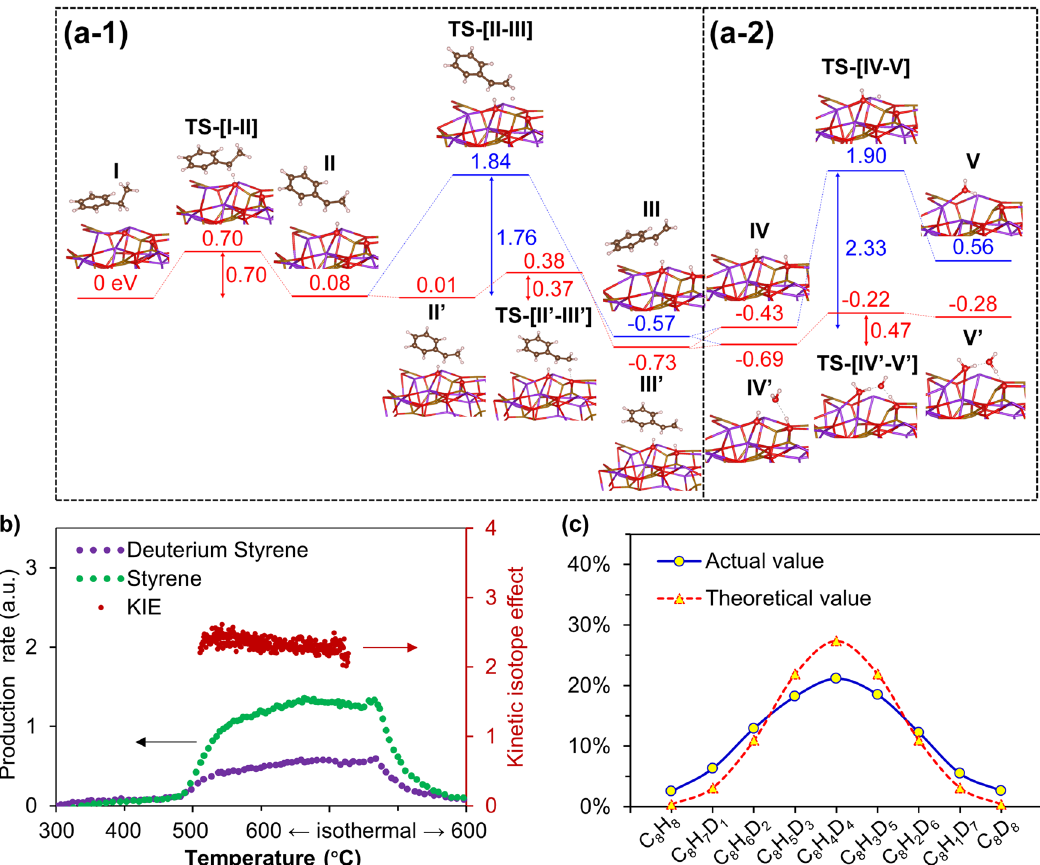
Fig. 6 Reaction pathway and rate-limiting step. a Computed energy potential pro fi les of each elementary step for the ethylbenzene ODH and water- assisted proton transfer and water formation ( a-1 corresponds to dehydrogenation steps and a-2 corresponds to water formation and desorption steps). b Kinetic isotope effect study with both temperature-programmed reduction and isothermal reduction of the redox catalyst using ethylbenzene and deuterium ethylbenzene. c Styrene isotopes distribution from isothermal ODH using co-feed of ethylbenzene and deuterium